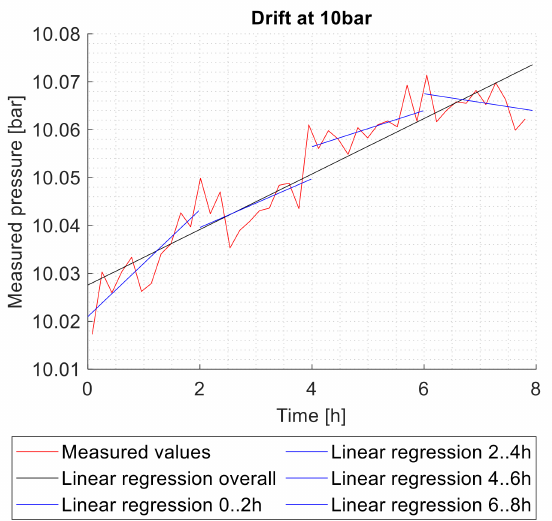
Figure 12. Drift at 10 bars reference pressure with linear regression